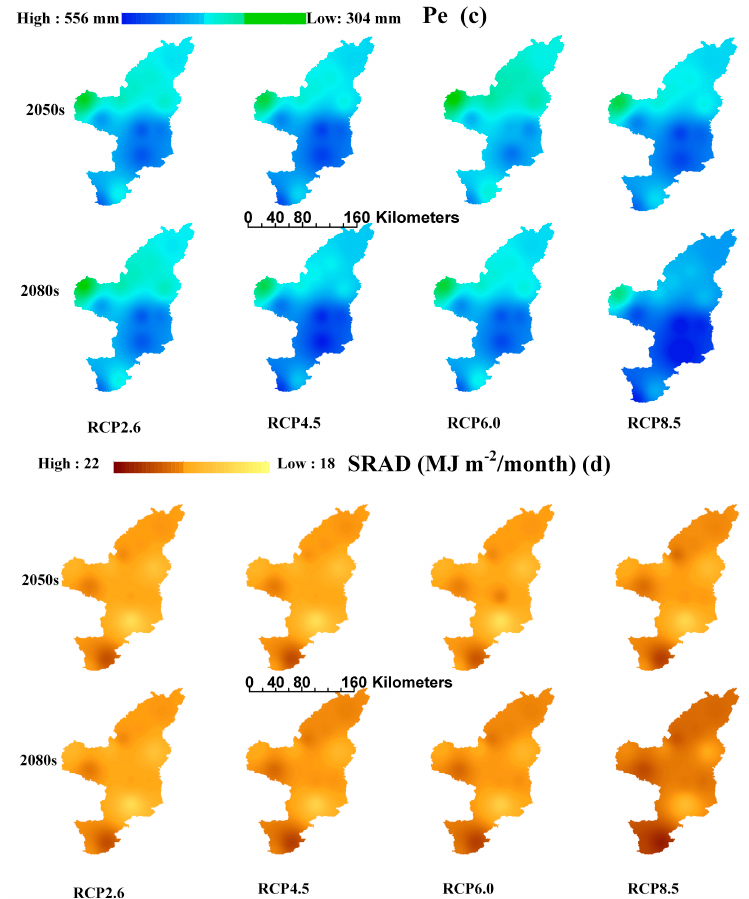
Figure 3. Spatial and temporal evolutions of the climate parameters in the 2050s and 2080s. Seasonal ( a ) maximum temperature ( ◦ C), ( b ) minimum temperature ( ◦ C), ( c ) precipitation (mm), and ( d ) solar radiation (MJ m − 2 / month). RCPs: representative concentration pathways.